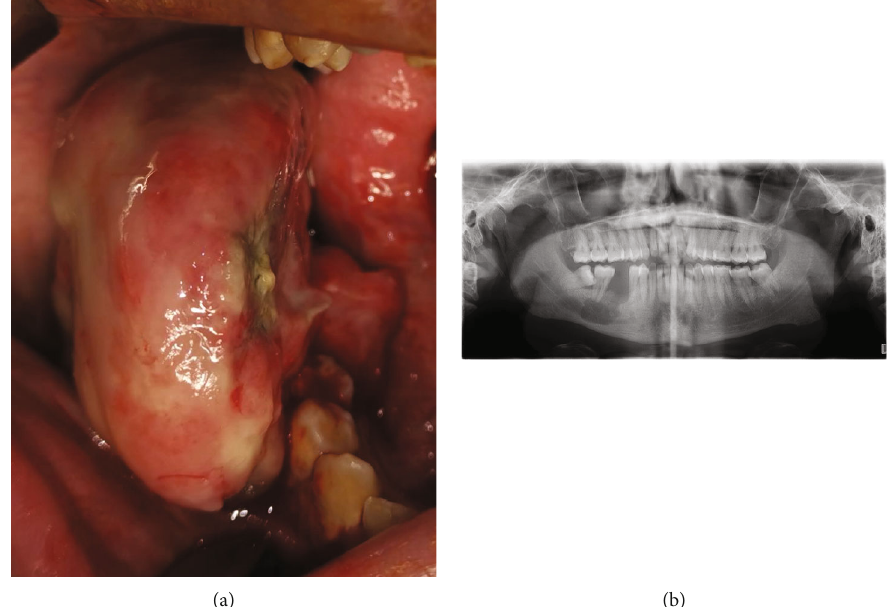
Figure 2: (a) Intraorally, the lesion obliterated the right buccal vestibule. (b) Orthopantogram revealed a unilocular radiolucency at the right